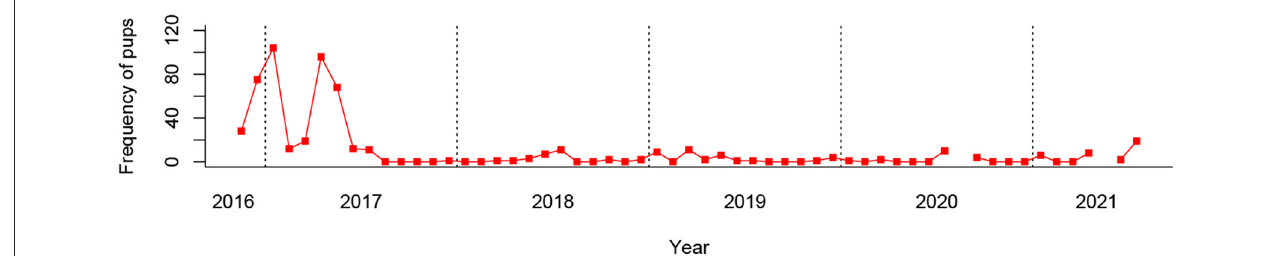
FIGURE 5 | Number of pups sterilized by month in Dehradun, India between 2016 and 2021.